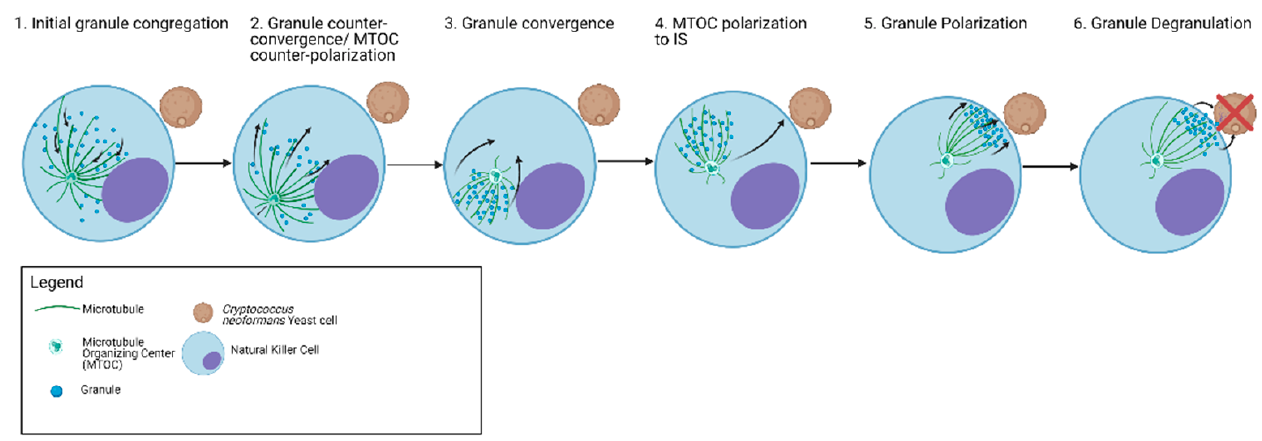
Figure 3. Graphical representation of Stages of granule trafficking during an NK cell mediated cytotoxic event against fungal pathogen C. neoformans.